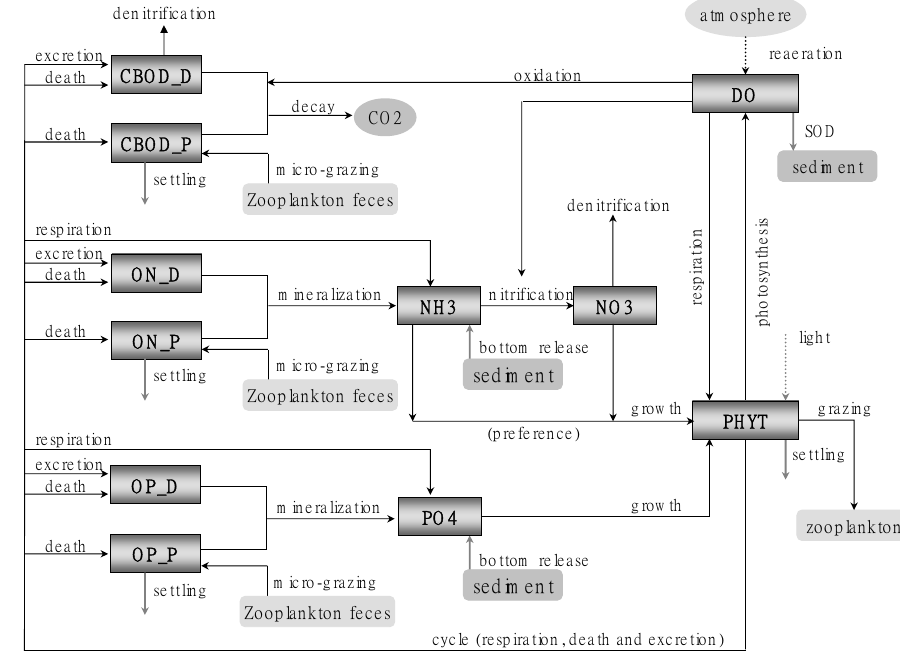
Figure 2. Major water quality interactions in WQDPM.